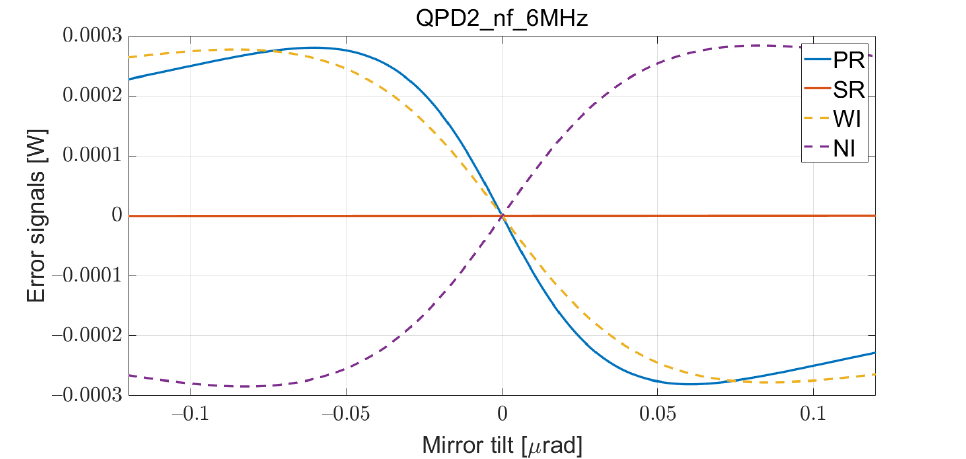
Figure 12. Signals ( left ) and compass plot ( right ) for B2 NF 6MHz comparing the signals produced by the misalignment of PR (blue), SR (red), WI (yellow, dashed), and NI (purple, dashed) mirrors [18].